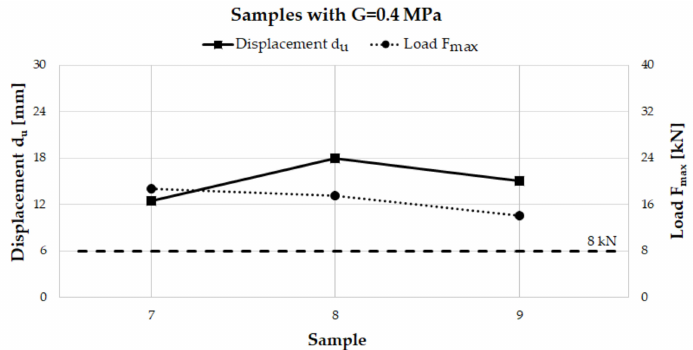
Figure 9. Test results in terms of displacements and loads for samples with G = 0.4